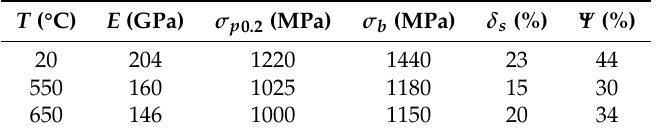
Table 1. Mechanical property of GH4169 alloy at different